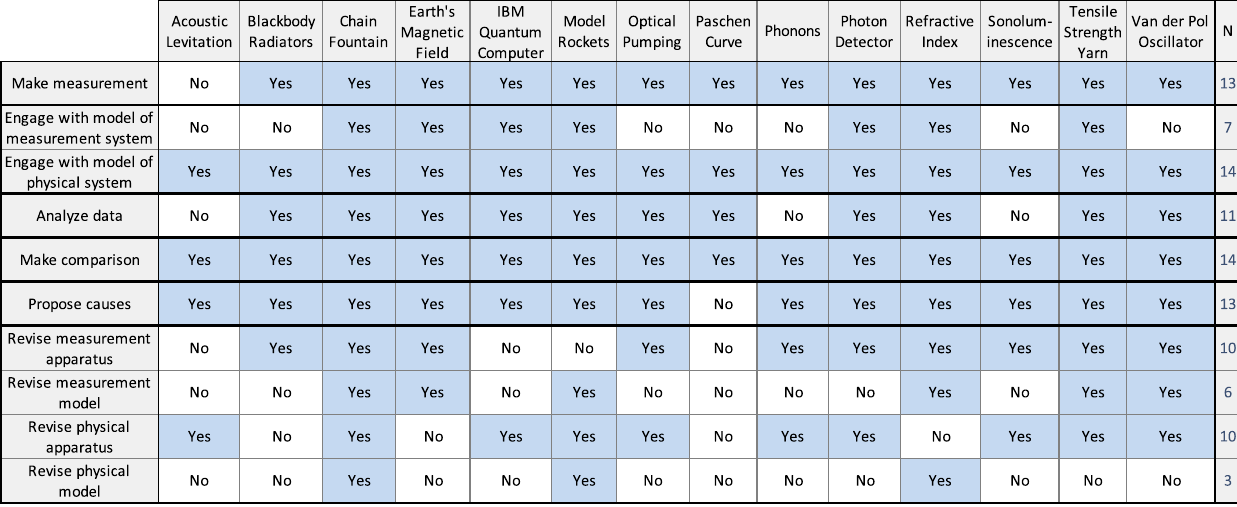
FIG. 3. Presence ( “ Yes, ” blue) or absence ( “ No, ” white) of the main modeling codes in each of the 14 projects. The number of projects that demonstrated evidence of each task are listed in the far-right